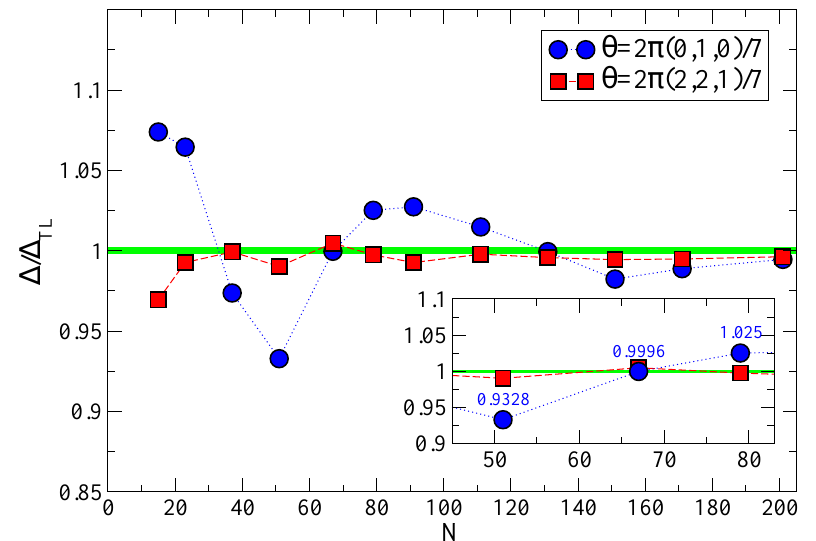
Figure 6. The odd–even scattering (OES) for different twist angles θ . The angle θ = 2 π ( 2,2,1 ) /7 yields minimum finite-size effects (FSEs) in the OES across all N . The angle θ = 2 π ( 0,1,0 ) /7 yields minimum FSEs for N = 67, a particle number routinely used in Quantum Monte Carlo (QMC) calculations for neutron matter (NM), as it has been demonstrated to yield minimum FSEs under